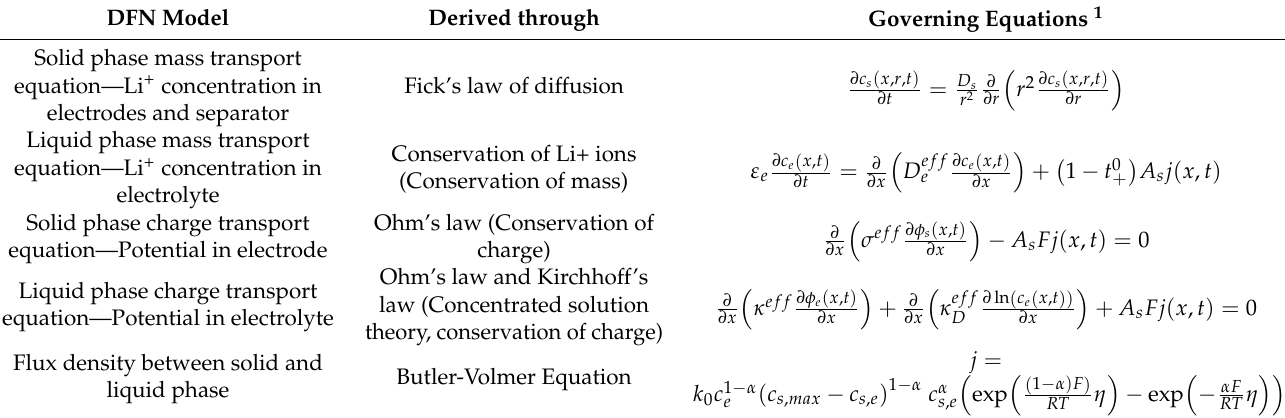
Table A1. Governing equations of DFN model along with the phenomenon that describes the diffusion, charge/mass conservation and flux density in DFN model [46,71]. DFN Model Derived through Governing Equations 1 Solid phase mass transport equation—Li + concentration in electrodes and separator Liquid phase mass transport